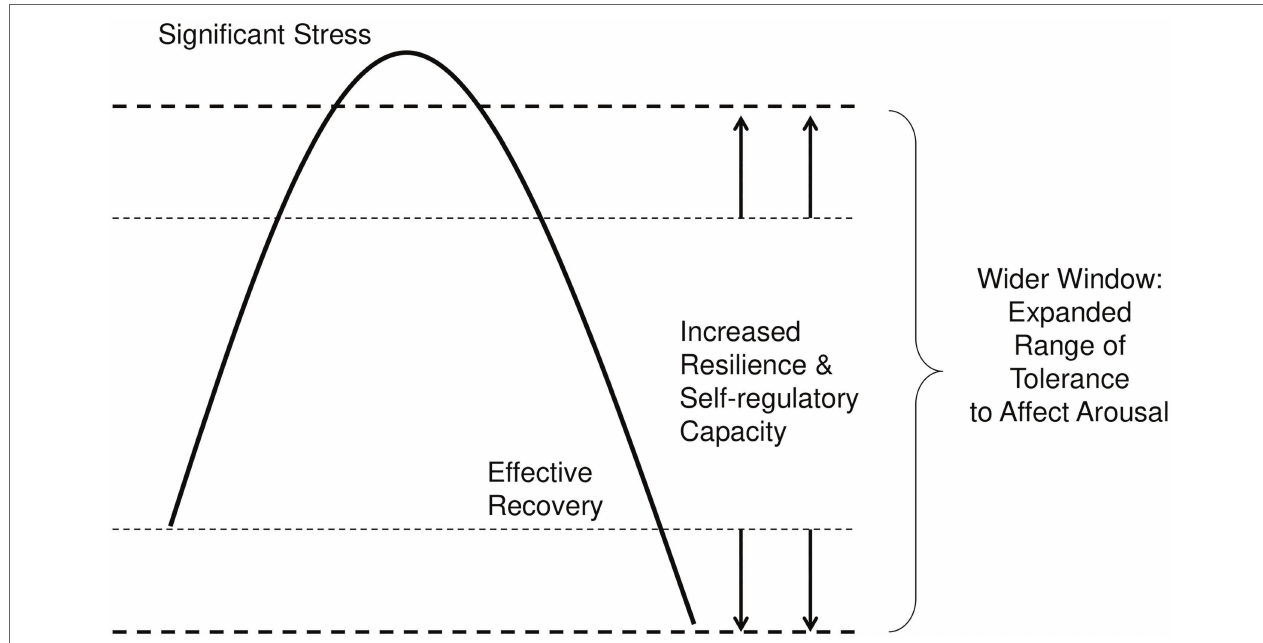
FIGURE 1 | Widening the Window through Complete Recovery. This figure depicts how individuals can widen their neurobiological window of tolerance to affect arousal. When they experience affect arousal outside their comfort zone, followed by a complete recovery, they create a wider window. The wider their window, the greater their self-regulatory capacity, and the greater their capacity to integrate System 1 and System 2 processes during